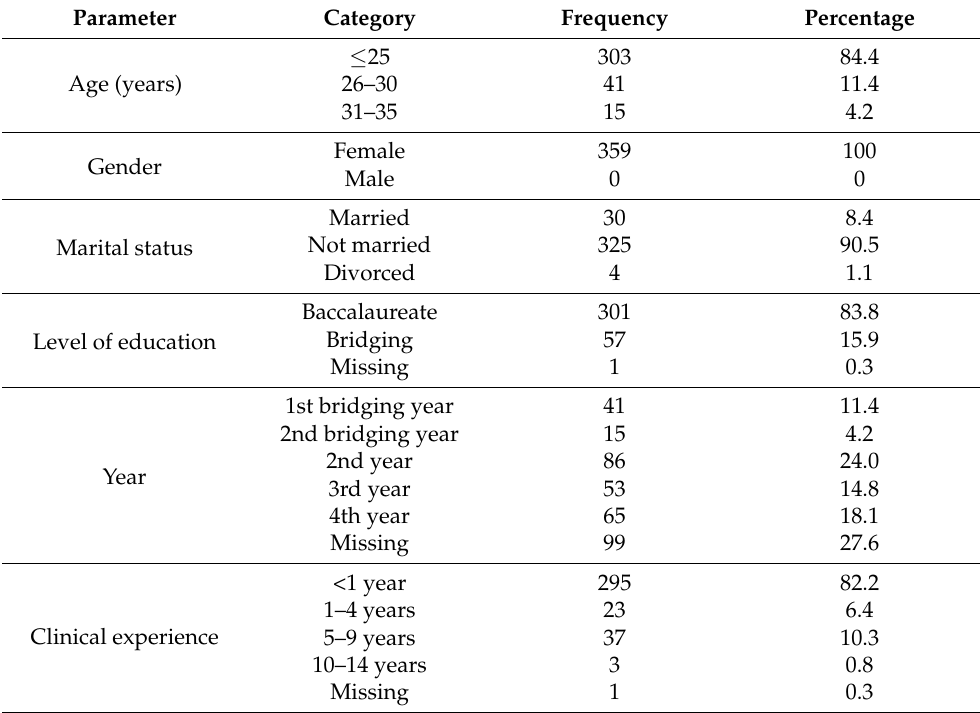
Table 1. Participants’